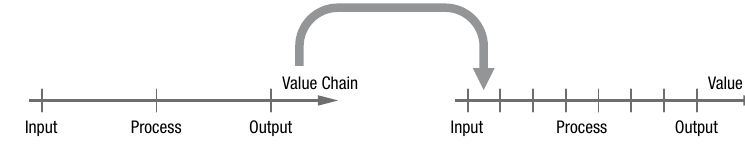
Fig. 1. Fine slicing of the value chain Source: Adapted from Pyndt and Pedersen